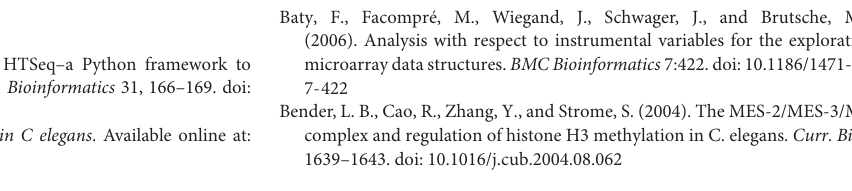
FIGURE S3 | Expression levels relative to P0 in F2, F4 fertile and F4 sterile for the top nine most upregulated contributors. The three independent lineages analyzed are represented by distinct line formats. FIGURE S4 | Comparison of lists of contributor genes to list of genes misregulated in set-2 mutant germlines at 20 ◦ C. *** p -value < 0.001. FIGURE S5 | TGF- β components upregulation in set-2 mutant germlines contributes to loss of identity. (A) Scheme of the TGF- β pathway present in C. elegans . Components upregulated during loss of germline identity are in red. (B) Expression relative to P0 of daf-4 , daf-14 , daf-8 , sma-4 , daf-3 , obr-3 , kin-29, sma-9 , daf-5, and sma-10 transcripts in F2, F4 fertile and F4 sterile. The three independent lineages analyzed are represented by distinctive line formats. FIGURE S6 | TGF- β components upregulation in set-2 mutant germlines. (A) Detection by smFISH of sma-3 transcript in P0 set-2 / + and F4 set-2 / set-2 germlines. Distal tip of the gonads are on the left. (B) Comparison of contributors with genes up- and downregulated in sma-2 mutant animals. Statistical significance (hypergeometric test); * p < 0.05, ** p < 0.01, *** p < 0.001. For downregulated contributors, p = 0.03 for under-enrichment in sma-2 oocyte upregulated genes, p = 0.17 for over-enrichment in sma-2 oocyte downregulated genes, p = 0.08 for under-enrichment in sma-2 L4 upregulated genes, p = 0.001 for over-enrichment in sma-2 L4 downregulated genes; for upregulated contributors: p = 5e-8 for over-enrichment in sma-2 oocyte upregulated genes, p = 0.43 for under-enrichment in sma-2 oocyte downregulated genes, p = 1.6e-32 for over-enrichment in sma-2 L4 upregulated genes, p = 0.03 for under-enrichment in sma-2 L4 downregulated genes. (C) Overlap between upregulated contributors and genes upregulated in sma-2 oocytes or sma-2 L4 stage animals. (D) Comparison of the list of 137 genes upregulated in sma-2 oocytes or sma-2 L4 stage animals and set-2 mutant germlines with ubiquitous genes, soma specific genes (soma), germline enriched genes (germline), the wTF3.0 list of transcription factors (TF), CEBP-1 targets (CEBP-1), LIN-15B activated genes (LIN-15B), X-linked genes (X-linked), mes-2 ; mes-4 upregulated genes ( mes up) and GLP-1 activated genes (GLP-1). Soma specific genes ( p = 2e-4) and LIN-15B activated genes ( p = 5e-4) are significantly over-represented in this dataset. * p -value < 0.05, ** p -value < 0.01, *** p -value < 0.001. TABLE S1 | List of 7238 genes, downregulated and upregulated contributors with ubiquitous/germline/soma classification and comparison with genes deregulated following P-granule knock-down. Description of germline- specific downregulated contributors. Description of soma-specific upregulated contributors. TABLE S2 | Raw data of hypergeometric test performed on data presented on Figures 2 , 3 and Supplementary Figures S4, S6 . TABLE S3 | Comparison with transcription factors (wTF3.0), LIN-15B activated genes and CEBP-1 targets. Description of transcription factors found in upregulated and downregulated contributors. TABLE S4 | Comparison of genes misregulated in mes-2 ; mes-4 mutants and genes activated by GLP-1/Notch and LIN-15B. TABLE S5 | RNAi targeting of positive contributors to the WCA PC1 in a set-2 ( lf ) background (full list of tested genes). TABLE S6 | Comparison between downregulated contributors and TGF- β